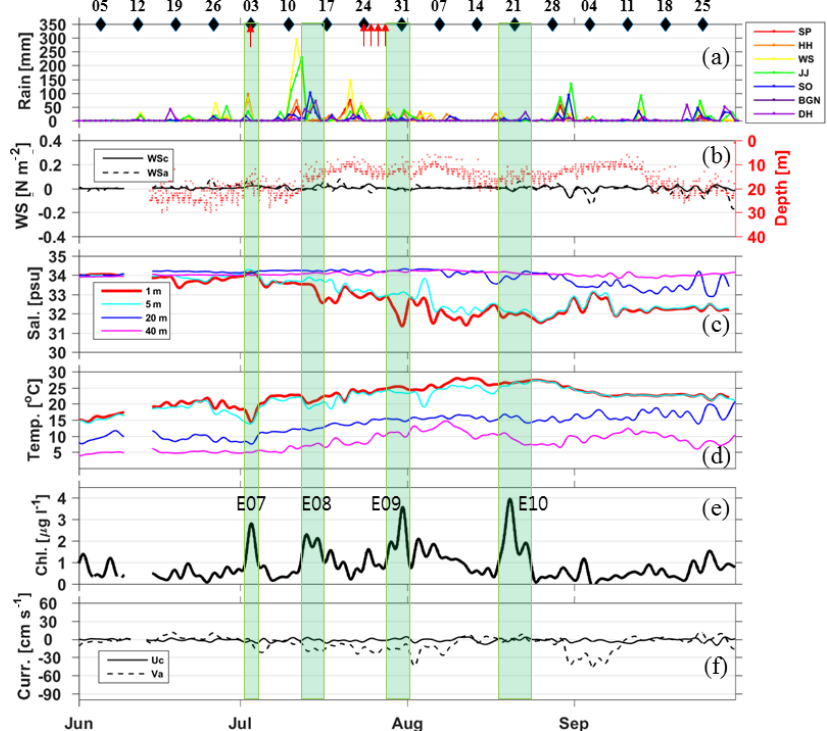
Figure 7. Same as Fig. 6 but for the 2013 bloom events labeled E07 to E10, and no typhoon occurrence.